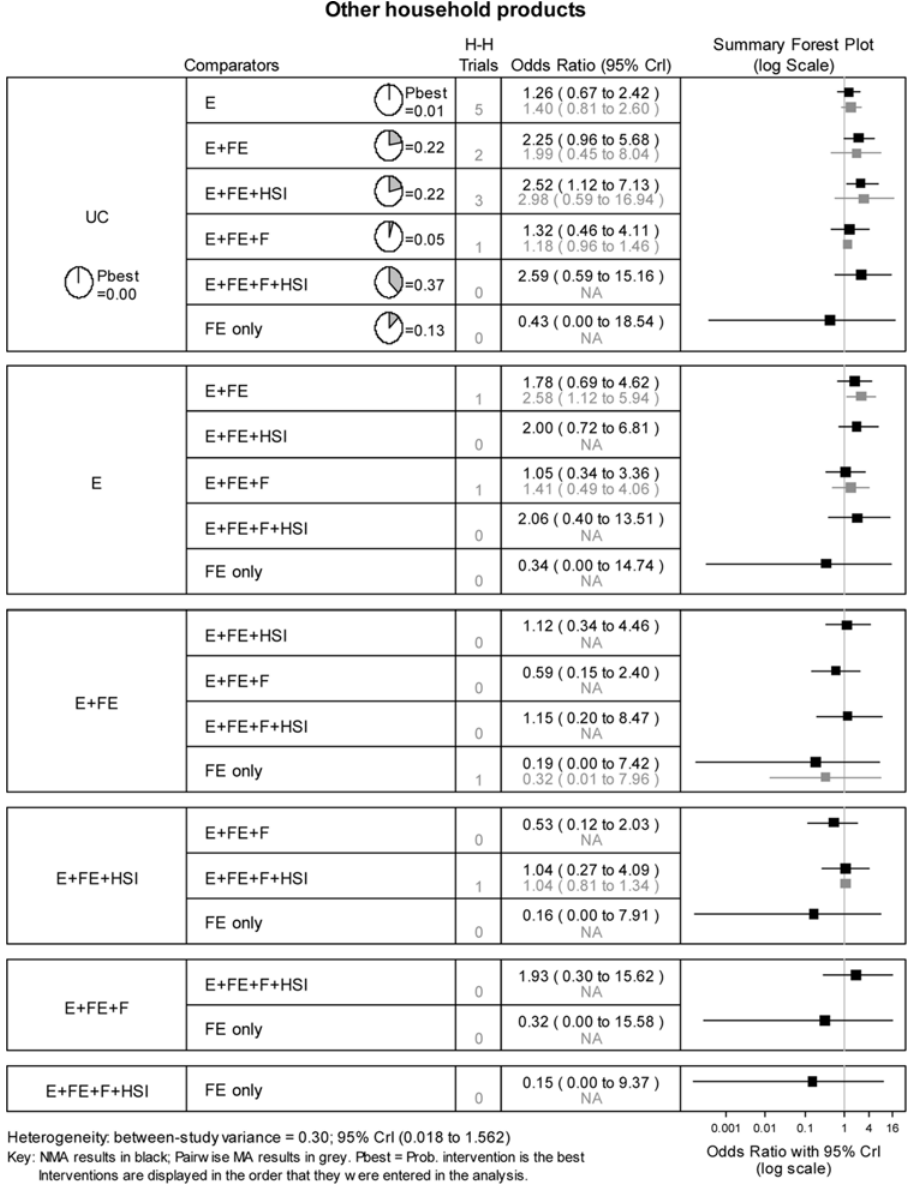
Fig 4. Network meta-analysis results for safe storage of other household products. H-H trials refer to the number of head-to-head trials available for the specified pairwise comparison.